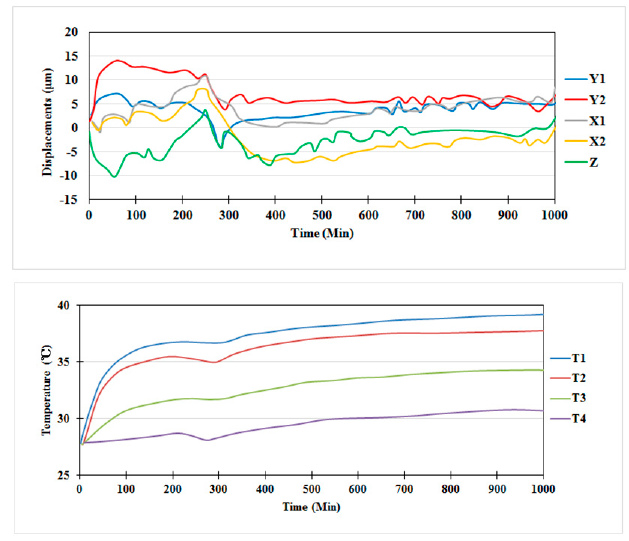
Figure 13. Temperature and displacement variations on the x -, y -, and z -axes controlled by the modified compensation system.